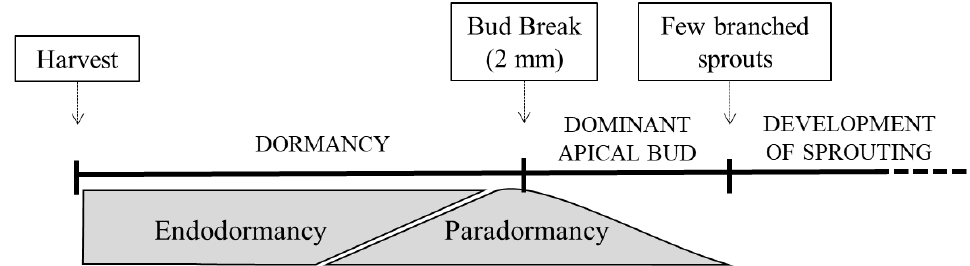
Figure 1. Schematic timeline from harvest to tuber sprouting under favorable conditions. Endodormancy is the first stage of tuber dormancy where the growth of meristems is inhibited. Once endodormancy weakens, there is a transition to paradormancy, and the apical bud will grow while the other meristems will be inhibited in paradormancy. Subsequently, the release of the paradormancy, allows for the appearance of secondary shoots that together with the apical bud form the plant through normal sprouting. Furthermore, endodormancy will become ecodormancy, and growth will be inhibited under unfavorable environmental conditions (e.g., low temperatures).